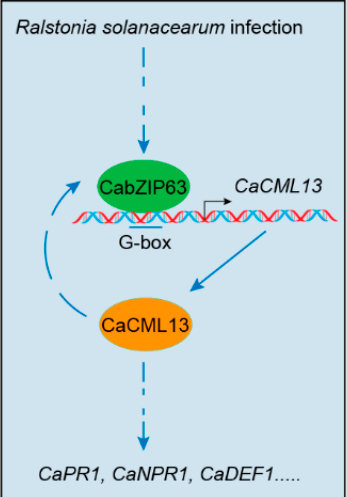
Figure 8. Proposed model of the positive feedback loop between CaCML13 and CabZIP63 in pepper response to R. solanacearum infection. The blue dotted arrows indicate the indirect process and the blue solid arrow indicates the direct process.